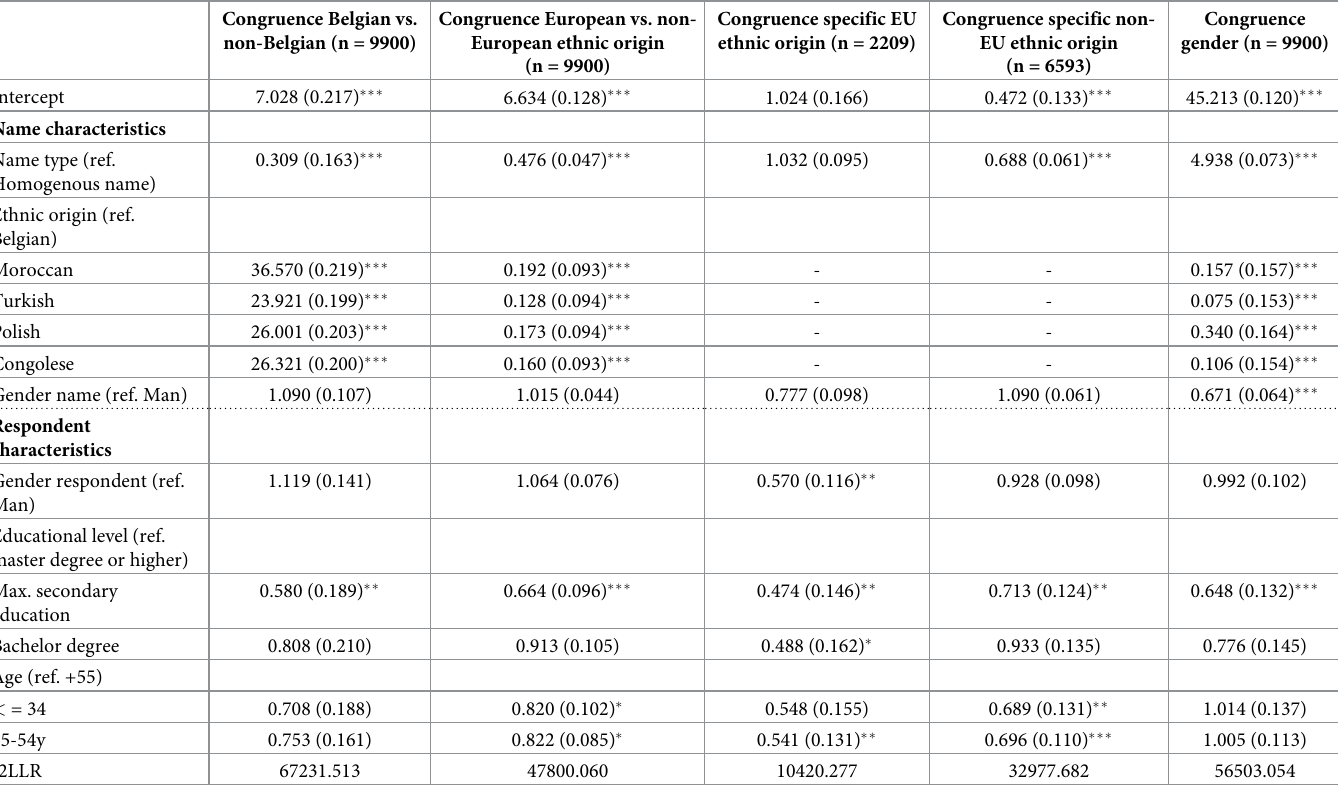
Table 2. Multilevel logistic regression analysis with individual level fixed effects on the congruence variables for ethnic-national origin and